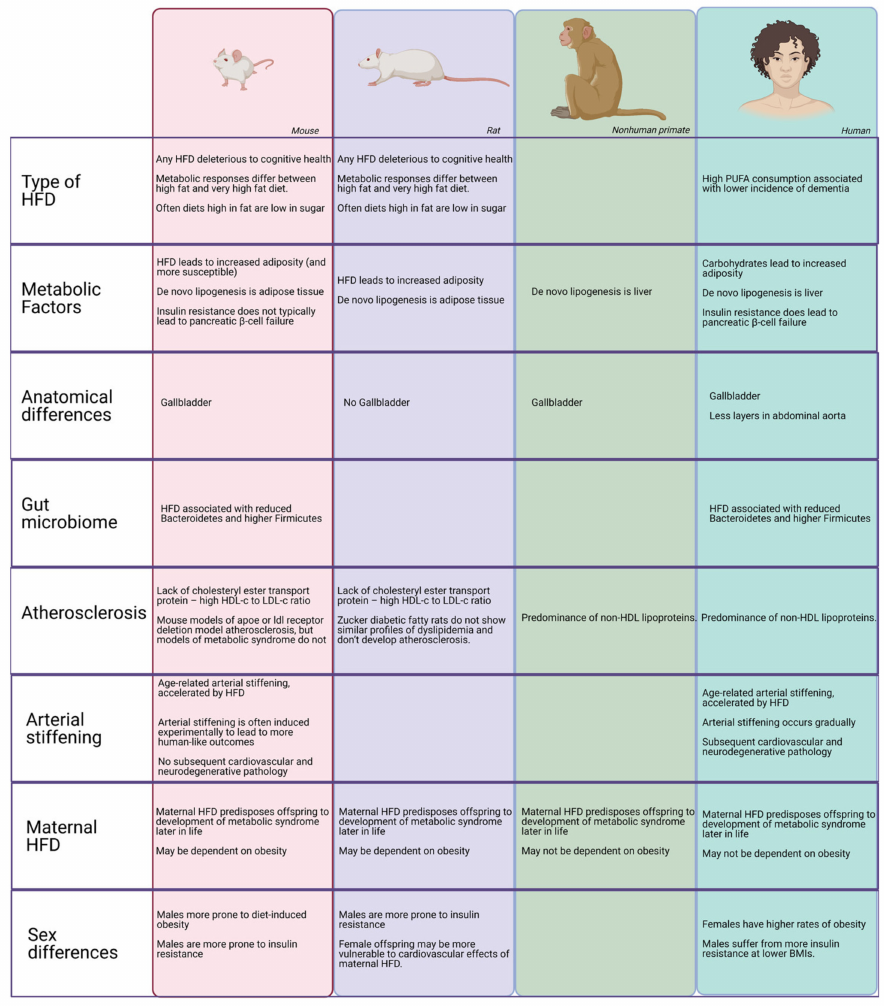
Figure 4. Species differences in HFD response. A representation of major species differences in the effects of HFD that may affect the